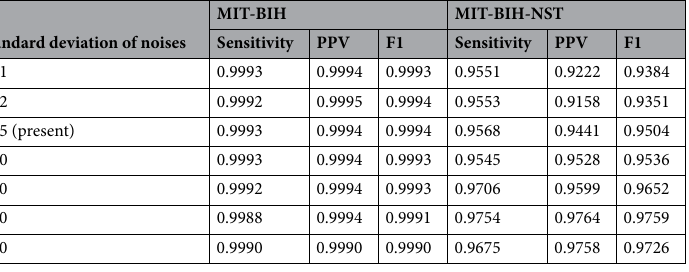
Table 7. Model performance in the MIT-BIH-NST database according to the noise amplitudes during training.